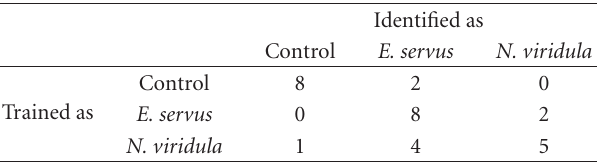
Table 4: Cross-validation of the training set used to train the E-nose to recognize headspace VOC emissions from undamaged (control) bolls and bolls damaged by Euschistus servus and Nezara viridula following 3 days of feeding